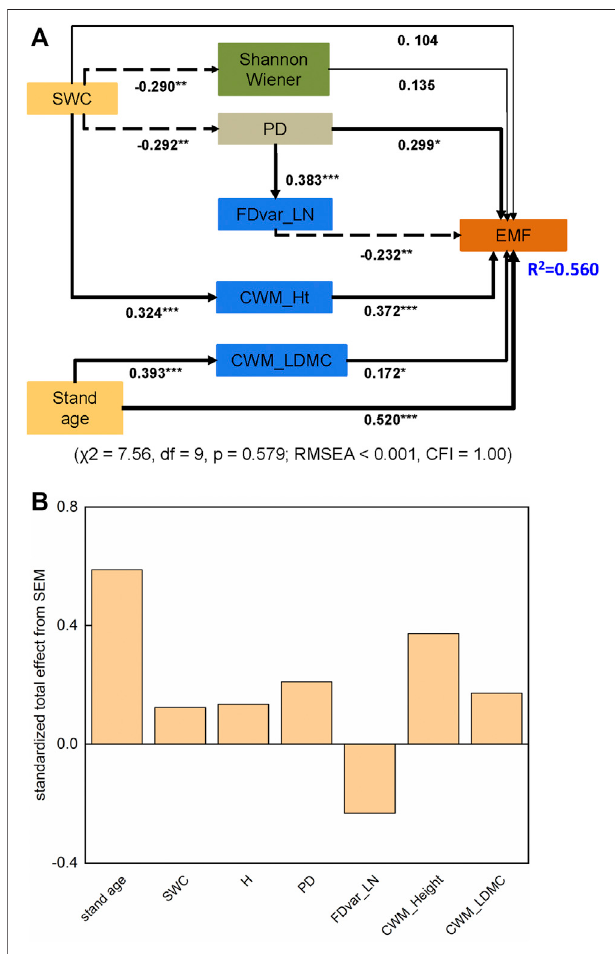
FIGURE 5 | (A) The structural equation model (SEM) in explaining variations of EMF along successional stages of the semi-arid grassland on the Loess Plateau. Dashed arrows re fl ect negative relationship, solid arrows re fl ect positive relationships and standardized path coef fi cients are shown on the path. The abbreviations are the same as those in Figure 2 . *, **and *** represent the signi fi cance levels of 0.05, 0.01 and 0.001, respectively. (B) The standardized total effect of different factors on EMF. The abbreviations are the same as those in Figure 2 .